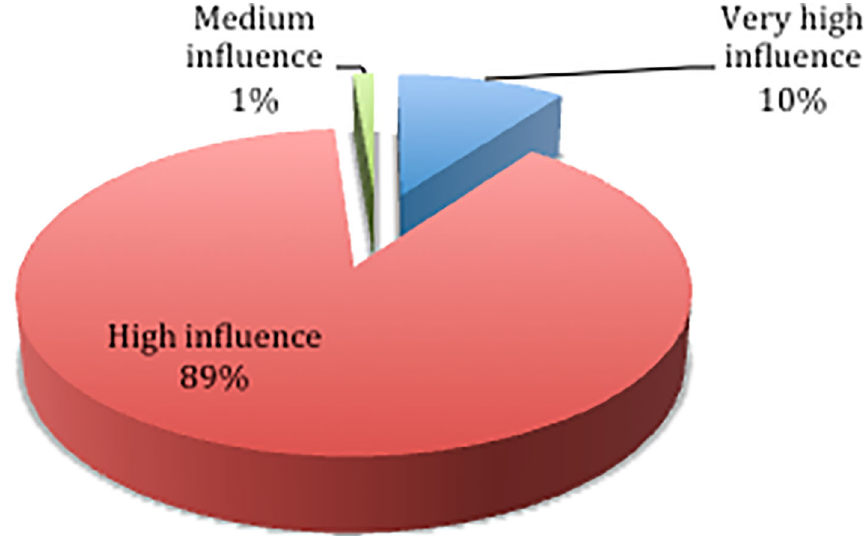
Figure 2. Percentage level of